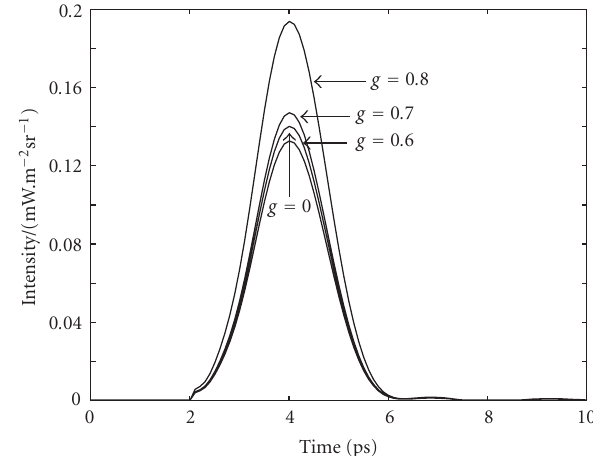
Figure 3: Few ray paths for a medium with a refractive index profile given by (14).